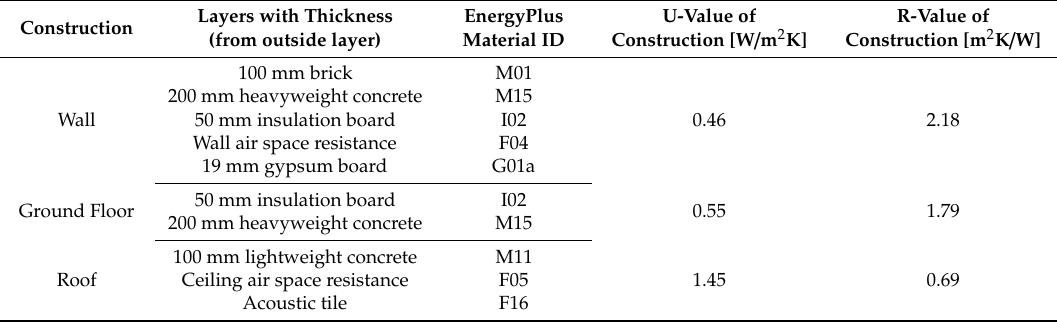
Table 1. Overview of considered building construction materials (source: [22]).